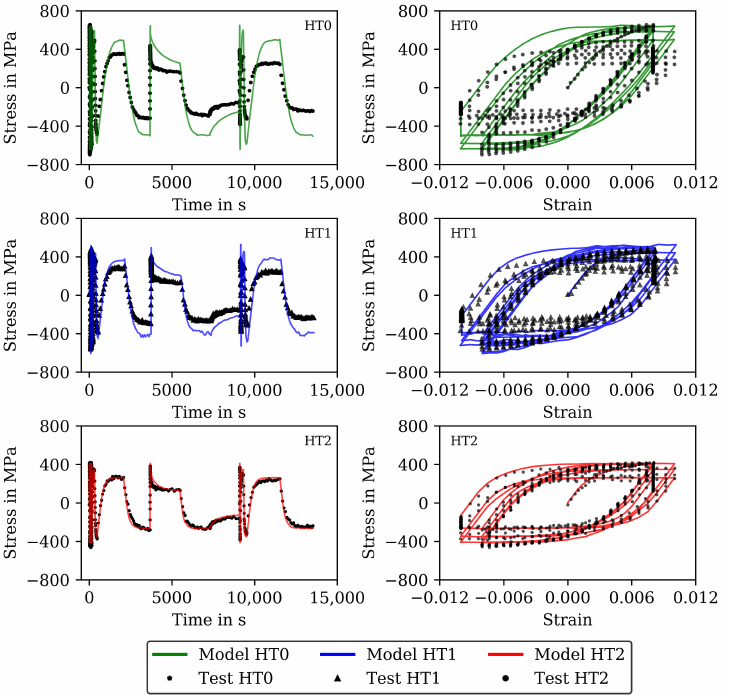
Figure 3. Measured stress and stress calculated with the model of step 1 for the initial (11) cycles of the CLCF tests at 650 ◦ C for the HT0, HT1 and HT2 material. Stress-time diagrams ( left ) and stress–strain hysteresis loops ( right ).